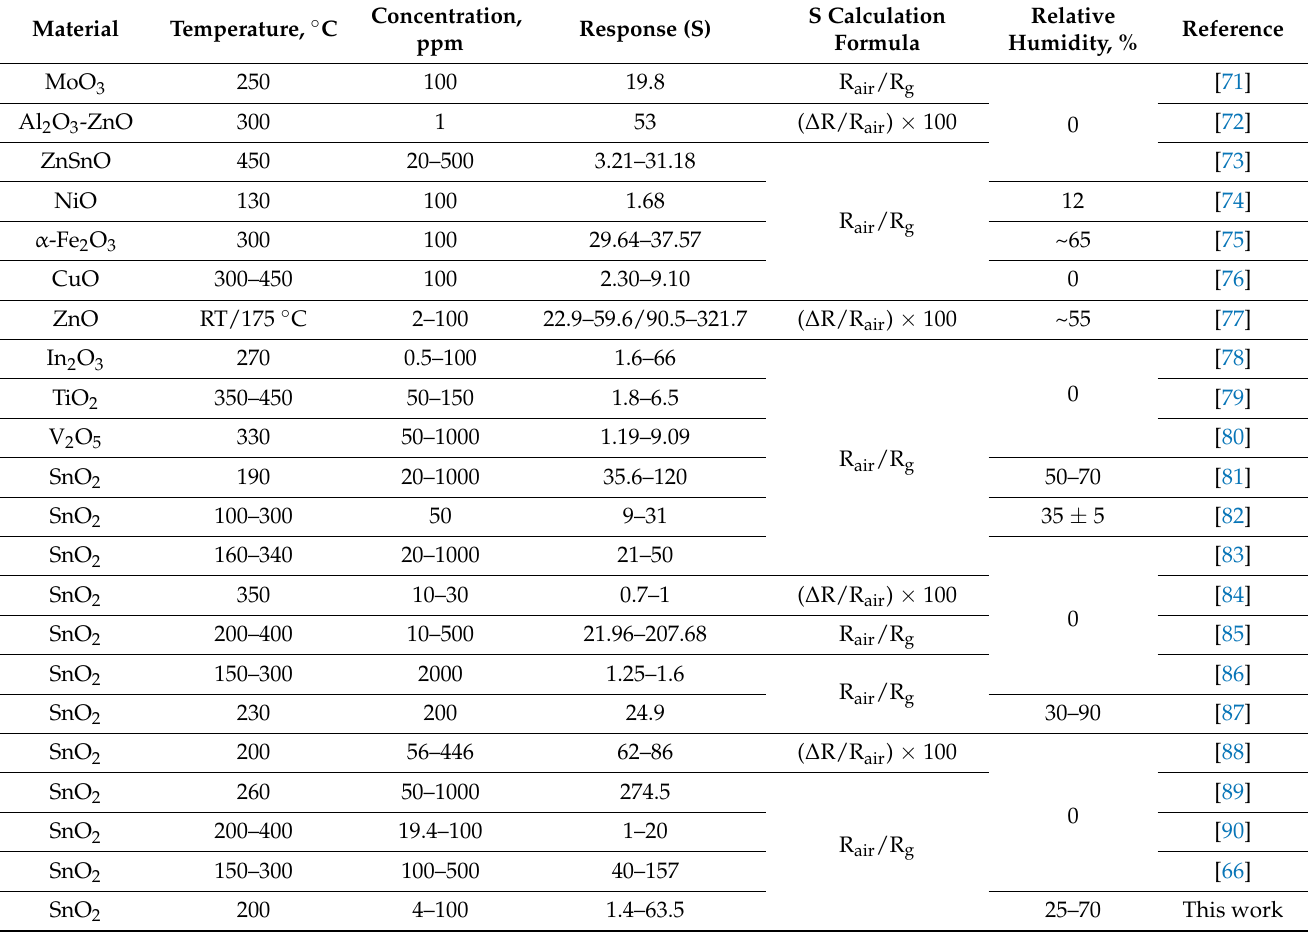
Table 1. Characteristics of metal oxide chemoresistive gas sensors for